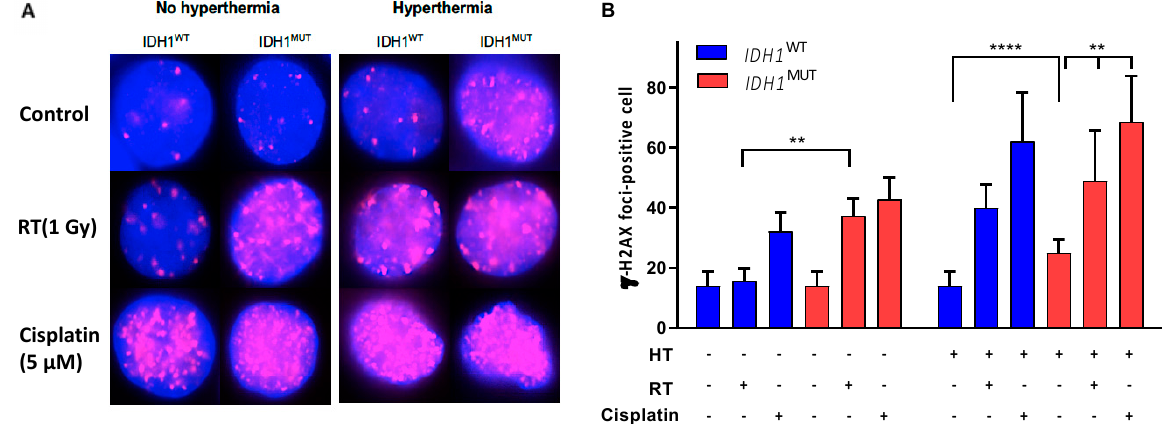
Figure 5. Double-strand breaks induced by hyperthermia, radiation (RT) and cisplatin in IDH1 WT and IDH1 MUT cancer cells. ( A ) Representative images of γ -H2AX foci in untreated cells (control), irradiated cells (1 Gy) and cells treated with cisplatin (5 µ M for 24 h), with or without hyperthermia. γ -H2AX was stained immunocytochemically (red) to demonstrate DNA double-strand breaks and with DAPI (blue) to demonstrate DNA in nuclei. ( B ) Plots of γ -H2AX-positive foci per cell after cisplatin, RT and hyperthermia exposure of IDH1 WT and IDH1 MUT HCT116 cells. Plots are visualized with 95% confidence intervals and significance levels are shown by ** p < 0.01 and **** p < 0.0001. p values were determined using one-way ANOVA to reveal the difference between treated and untreated cells, using Tukey correction for multiple